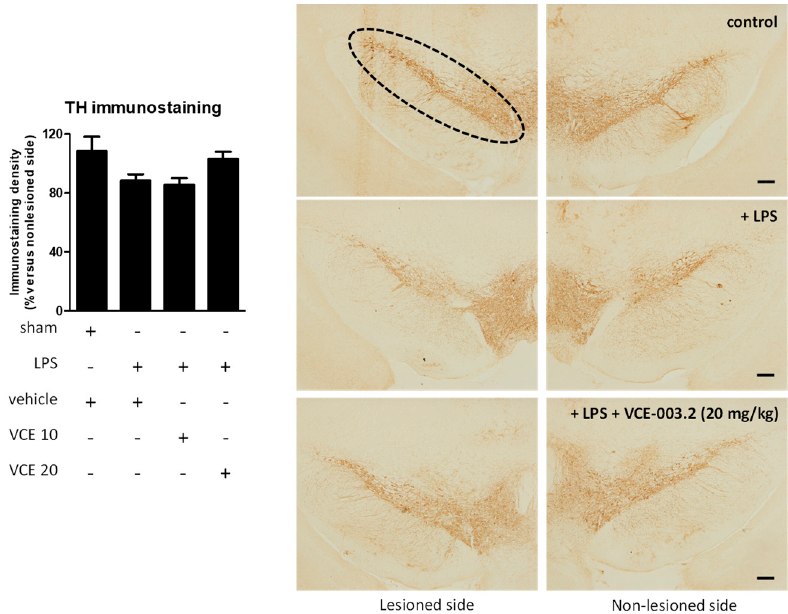
Figure 2. Preference for the ipsilateral paw measured in the cylinder rearing test in control and LPS- lesioned mice orally treated for 28 days after lesion with vehicle (corn oil) or VCE-003.2 at the dose of 20 mg/kg (VCE 20). Data correspond to only one week after the onset of the treatment (post-lesion), or to only one day before the autopsy and after four weeks of treatment (before autopsy). Values are means ± SEM of more than six subjects per group. Data were assessed using the one-way analysis of